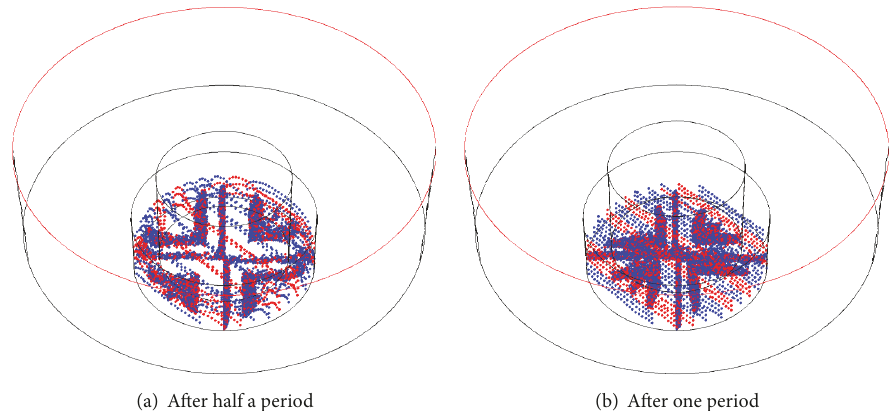
Figure 4: Gap flow field with 0.5 mm deep hole.